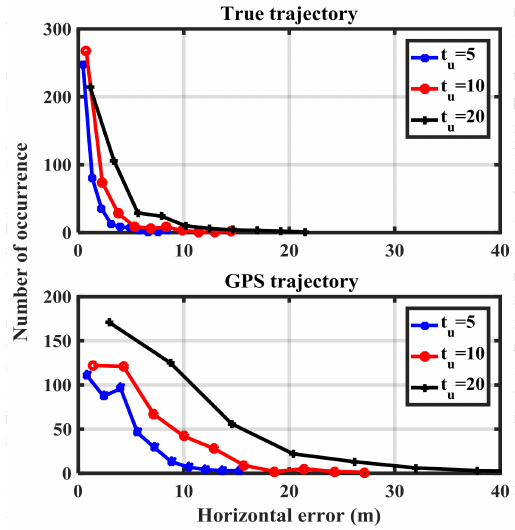
Figure 12. Histogram of the detection metric values for reference and GPS trajectories for different update intervals.